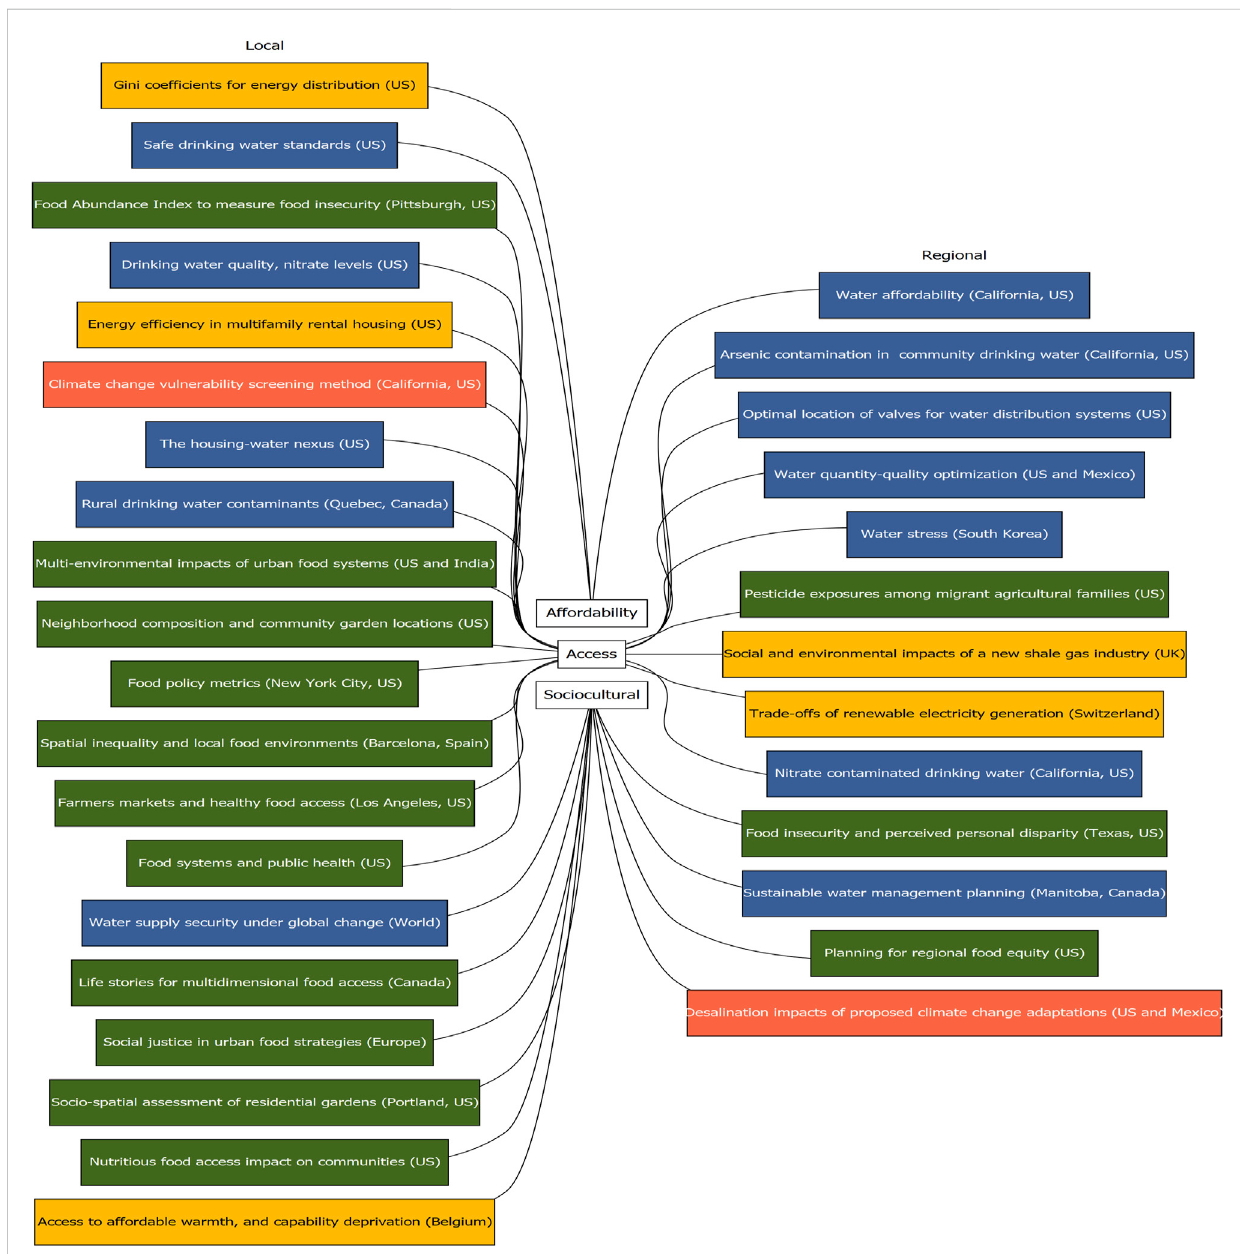
FIGURE 5 Local-andregional,-scalestudytopics,locationsandinteractionsbytypeofequityintegration(affordability,access,sociocultural).Thecolorsinthis fi gure follow thoseinFigure 3and Figure 4:Green denotesfood articles, yellowdenotesenergy articles, blue denotes water articles, and orange denotes nexus articles.